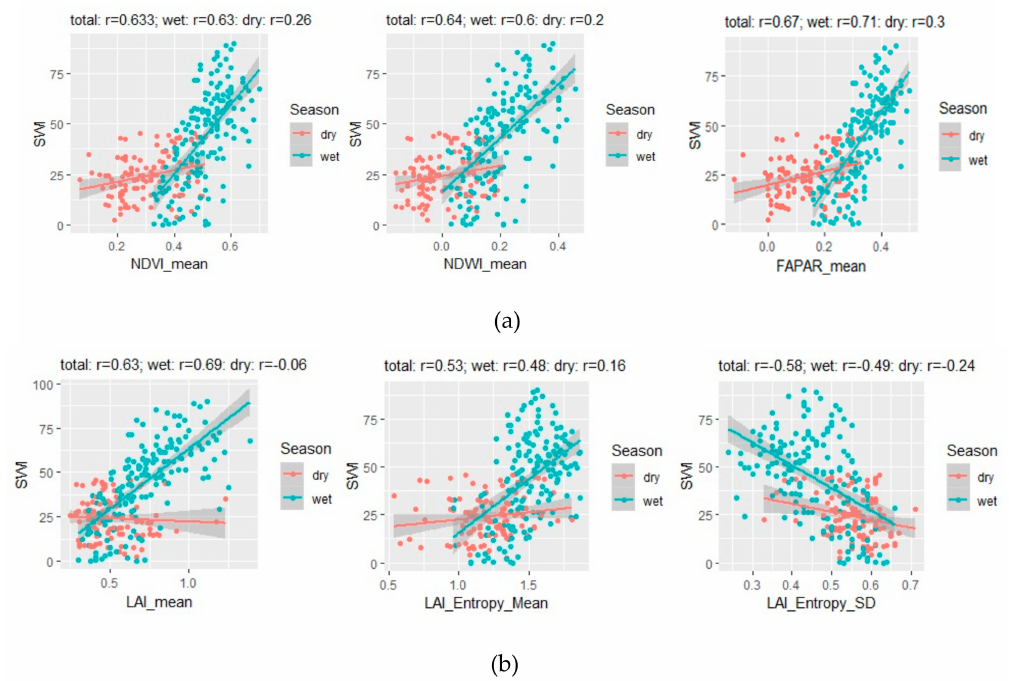
Figure 2. Selected scatterplots showing the distribution of observation by season, and the relationship between SWI and key VI statistics for the 28 samples sites across the Delta. Only the top-performing statistics (in terms of r values) are shown here. Blue indicates wet season and red for dry season. Grey lines display the confidence interval at 0.95. In each panel: ( a ) Correlating NDVI, NDWI, and FAPAR mean to SWI; ( b ) Correlating LAI mean, LAI entropy mean and SD to